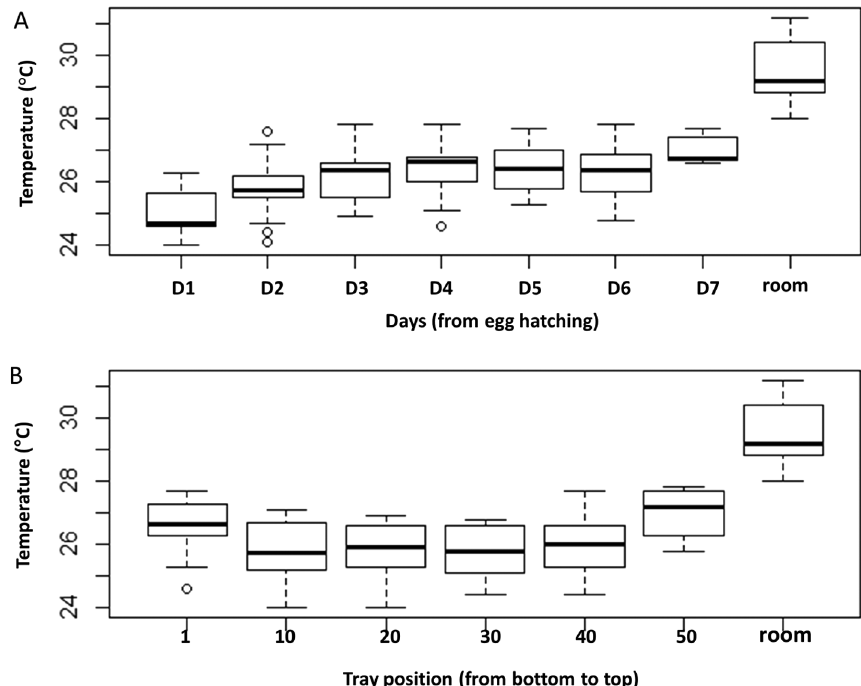
Figure 2. (A) Rearing water temperature variation during the course of rearing and (B) across the positions of the tray inside the rack. Water temperature increased signi fi cantly with time of rearing and between trays within the rack. Results are expressed as mean ±